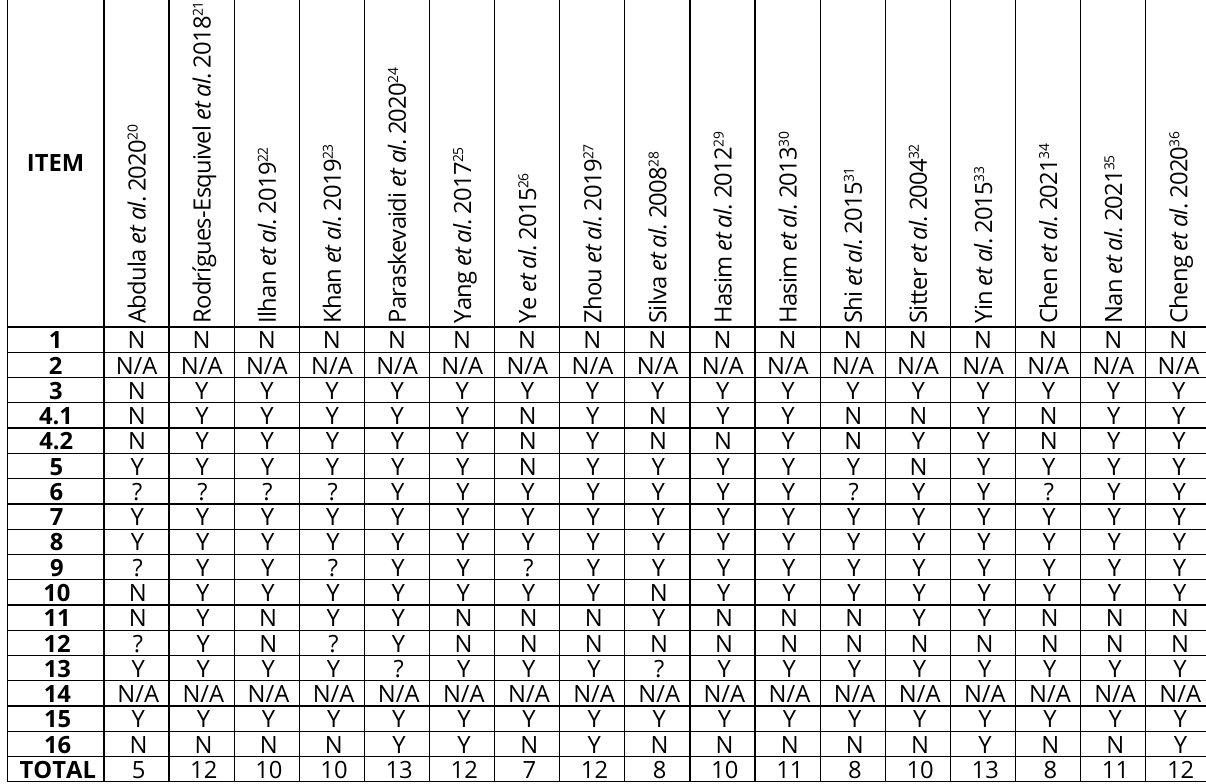
Table S1 - QUADOMICS evaluation of the studies included in the systematic review.